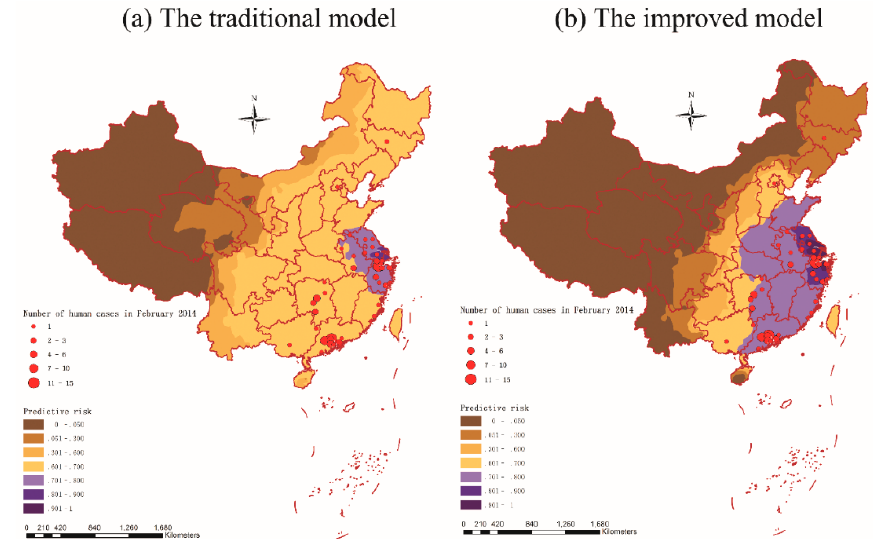
Figure 6. Predictive risk maps of A(H7N9) human infections in China based on the traditional logistic regression model ( a ) and the improved logistic regression model ( b ). Locations of the 101 influenza A(H7N9) cases in February 2014 are also indicated in the two maps.